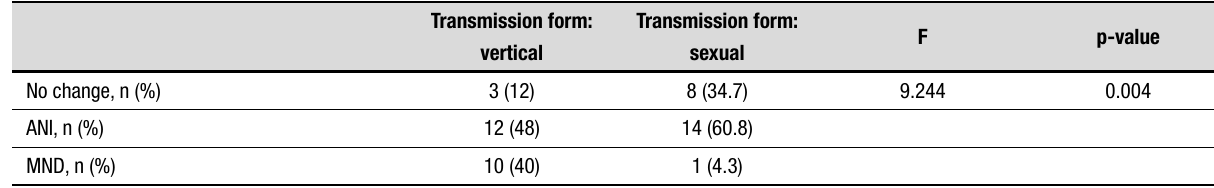
Table 2. Frequency of cognitive changes.